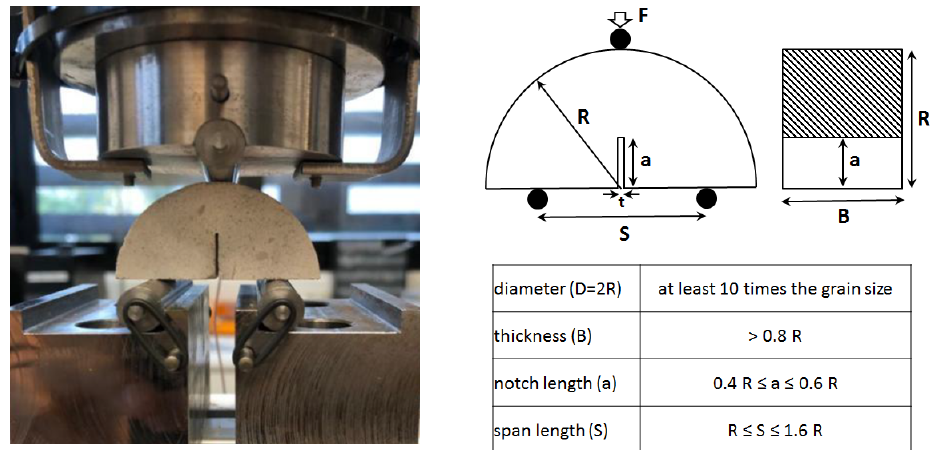
Figure 4. The new device developed at GEC laboratory for measuring the mode I fracture toughness. The sample geometry is given on the right and the requirements for the different parameters are summarized in the table.